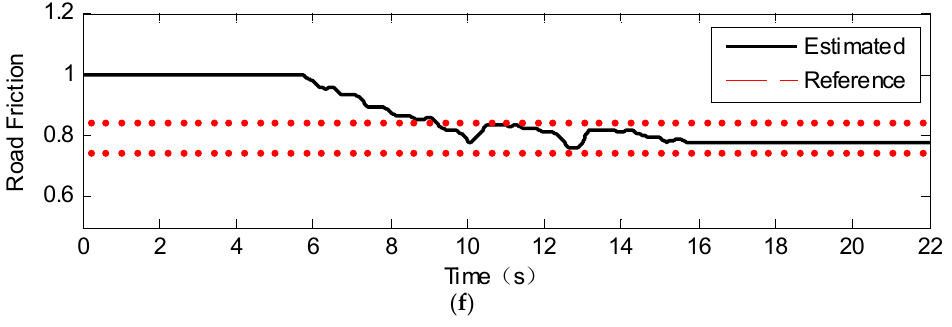
Figure 7. Results of the slalom test: ( a ) vehicle speed; ( b ) steering wheel angle and yaw rate; ( c ) longitudinal and lateral acceleration; ( d ) self-aligning torque at the kingpin; ( e ) distance between the vehicle and the left lane line; ( f ) road friction coefficient.